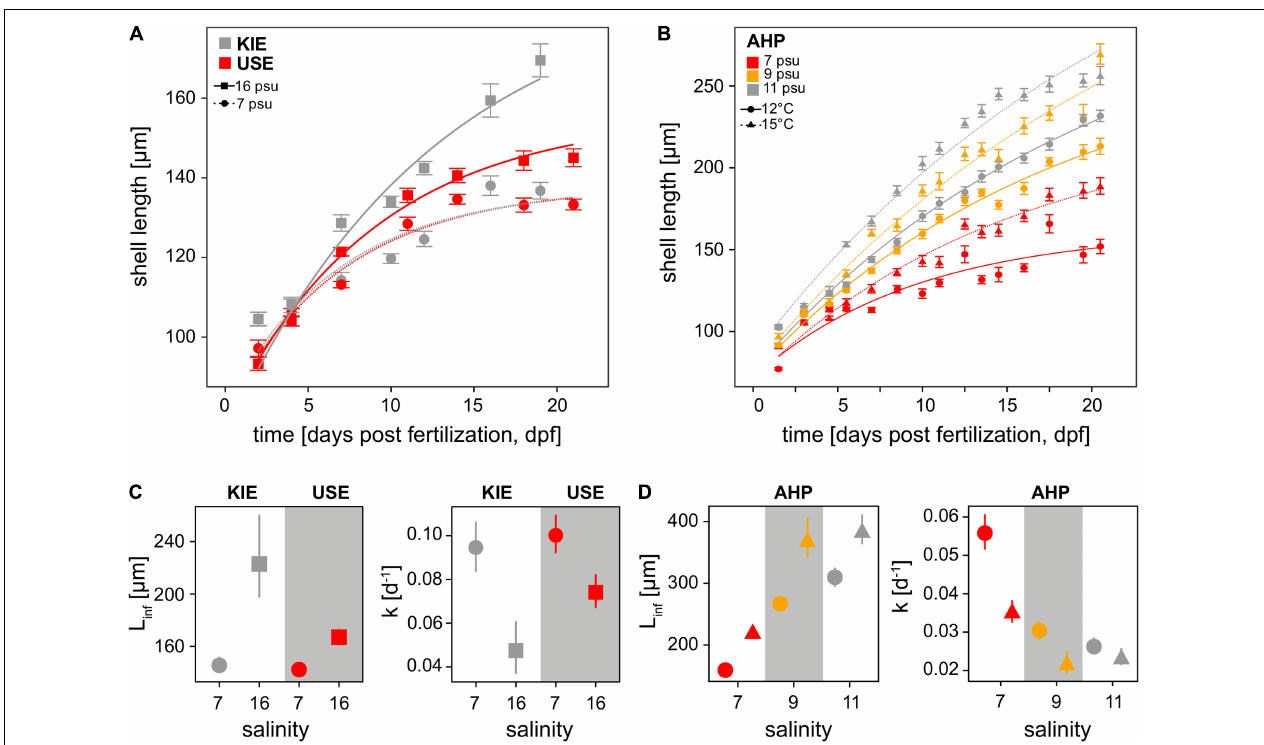
FIGURE 2 | Growth rates. Shell length ( µ m) increase over time of all treatments throughout the course of populations comparison (A) and desalination experiments (B) fitted to von Bertalanffy growth models (VBGM). Mean asymptotic average length ( L ∞ ) and mean Brody growth coefficient (K) estimated using the VBGM for the different treatments of the population comparison and simulated desalination experiments are represented in panels (C,D) , respectively. Symbols represent means and 95% confidence